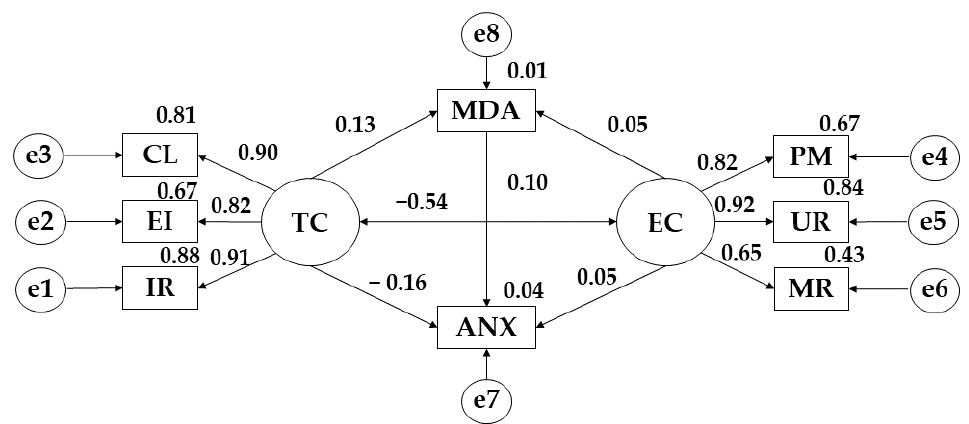
Figure 3. Theoretical model proposed for participants showing a medium level of weekly PA. Note: EC = Ego climate; TC = Task climate; PM = Punishment for mistakes; UR = Unequal recognition; MR = Member rivalry; CL = Cooperative learning; EI = Effort/improvement; IR = Important role; ANX = Anxiety; MDA = Mediterranean diet adherence. Table 3. Structural model for participants showing a medium level of weekly PA. Associations between Varia-